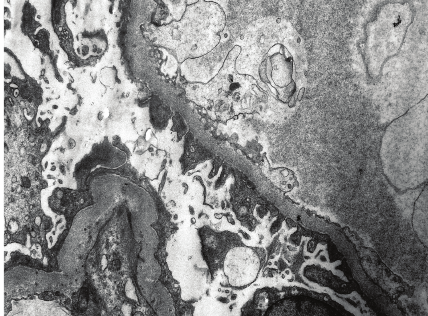
Figure 1: Light microscopy of the second biopsy shows mild mesangial matrix expansion and increase in mesangial cell number with focal accentuation (PAS, 200x).